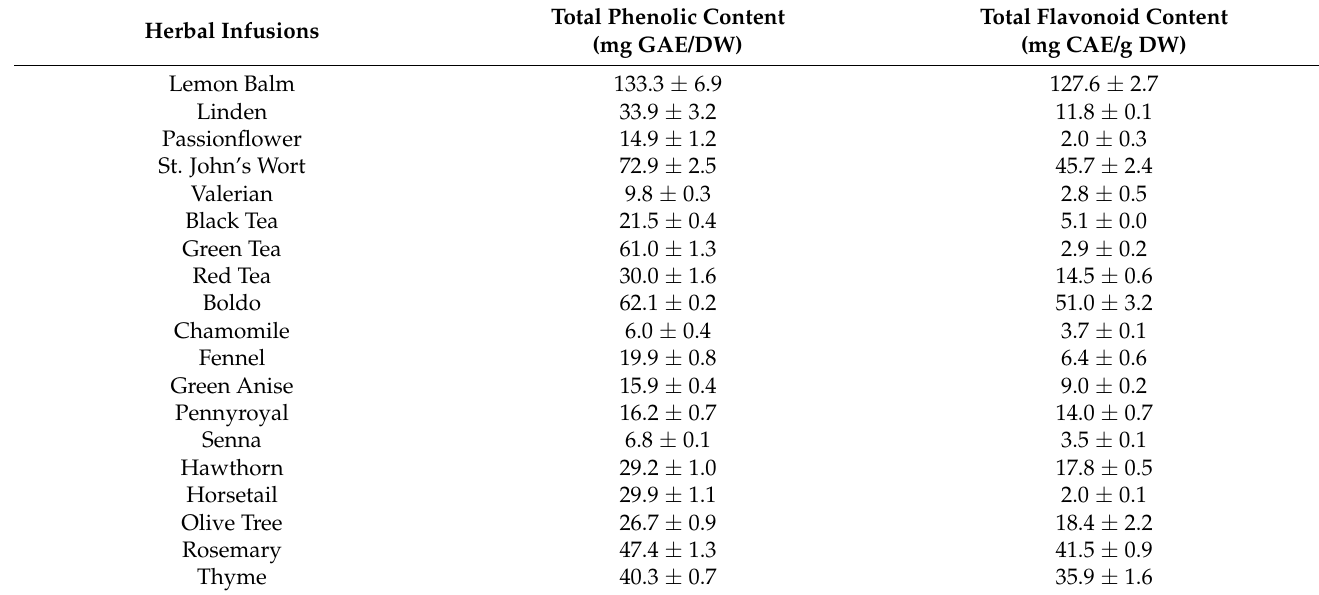
Table 1. Total phenolic content expressed in mg of gallic acid equivalents per g of dry weight (mg GAE/DW), and total flavonoid content in milligrams of chlorogenic acid equivalents per gram of leaf dry weight (mg CAE/g DW) of herbal infusions. Adapted from Herrera et al. [49].